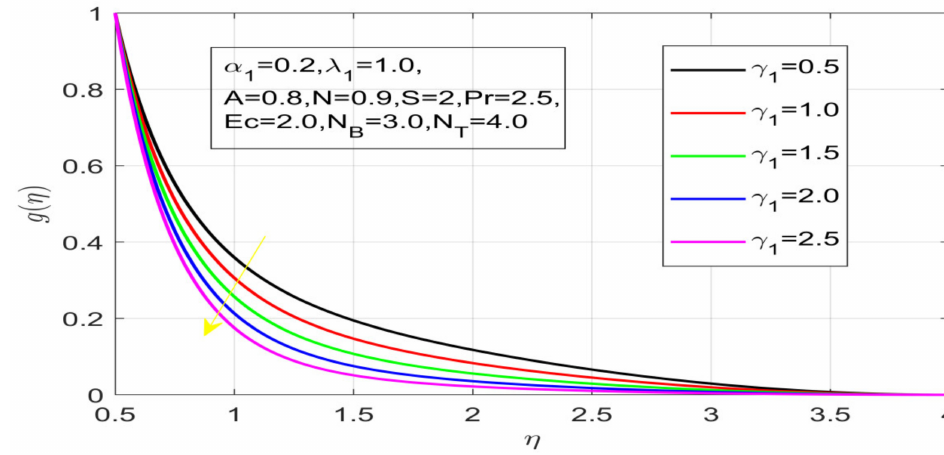
Figure 9. Influence of γ _1 on azimuthal velocity.